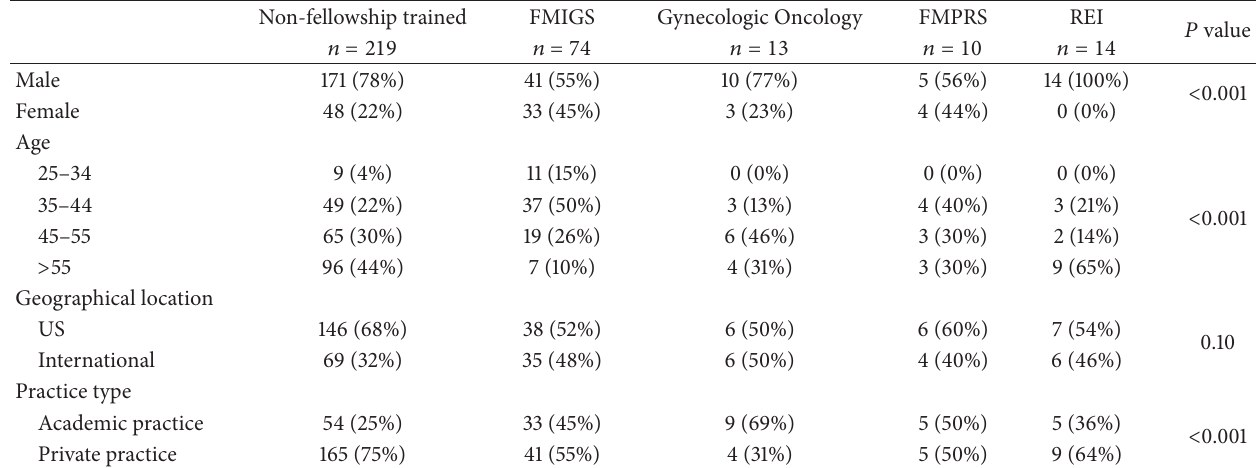
Table 1: Demographics of study participants.